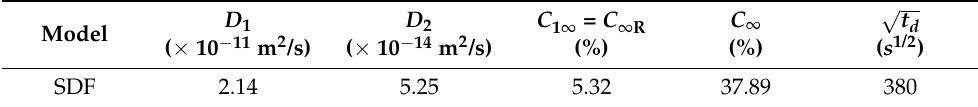
Table 4. Moisture diffusion sequential dual Fickian (SDF) law coefficients of the covering rubber.